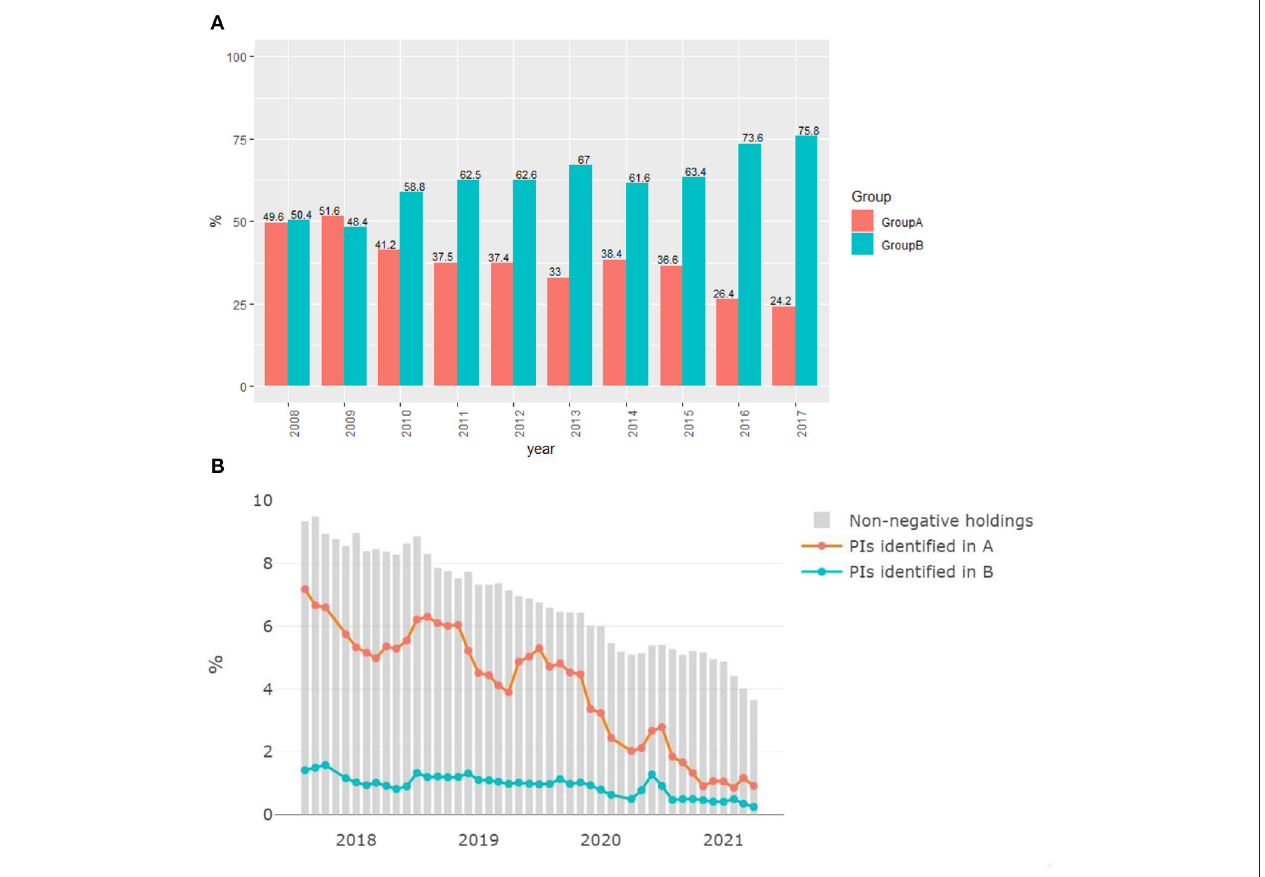
FIGURE 4 | (A) Proportion of imports going to either G A or G B . (B) Proportion of all non-negative holdings in Scotland is shown in bar graph. While the lines present the proportion of identified living PIs in both